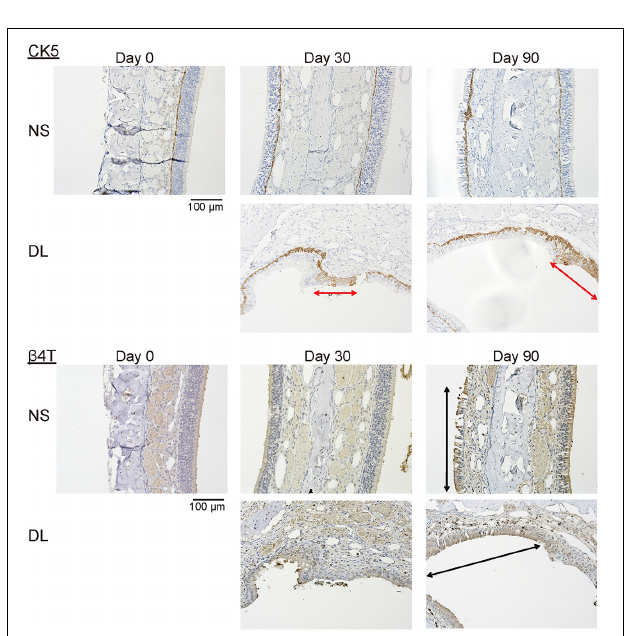
FIGURE 5 | Representative images of sections of the nasal mucosa stained with antibodies against CK5 and β 4T (magnification, 200 × ). CK5 expression was recognized in a part of the repaired nasal epithelium in the upper lateral (DL) area on days 30 and 90 after surgery (red arrows). β 4T was expressed in a part of the villous brush border of the columnar epithelium of the nasal septum (NS) and the DL area on day 90 (black